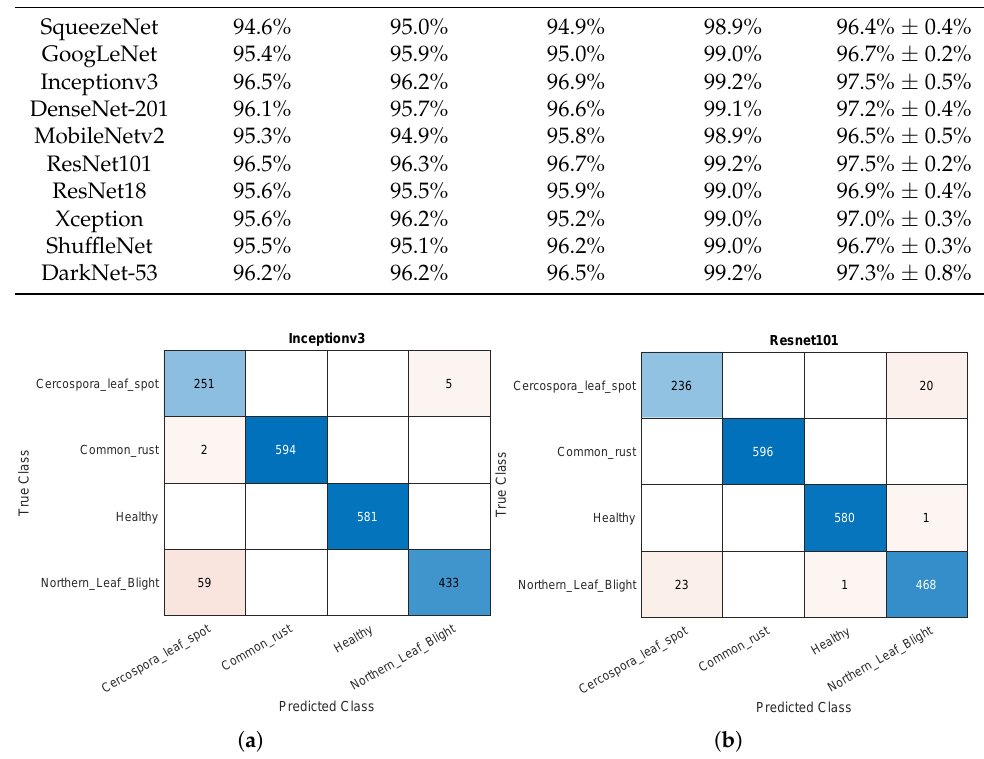
Figure 3. Sample confusion matrices for the Inceptionv3 and ResNet101 models using 50% of the data for training: ( a ) Inceptionv3. ( b ) ResNet101.